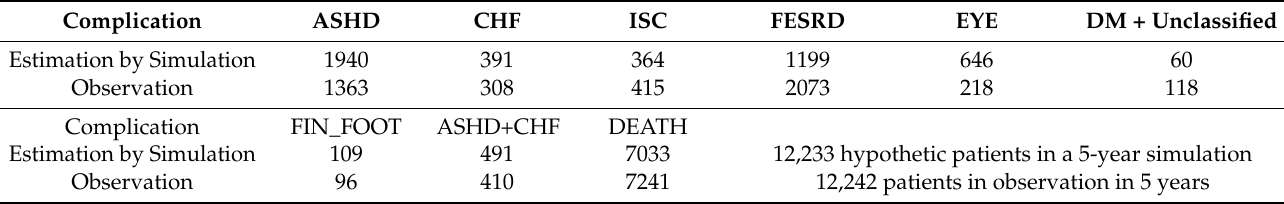
Table 7. Simulation results versus observations for study complication in type 2 diabetes mellitus over 5